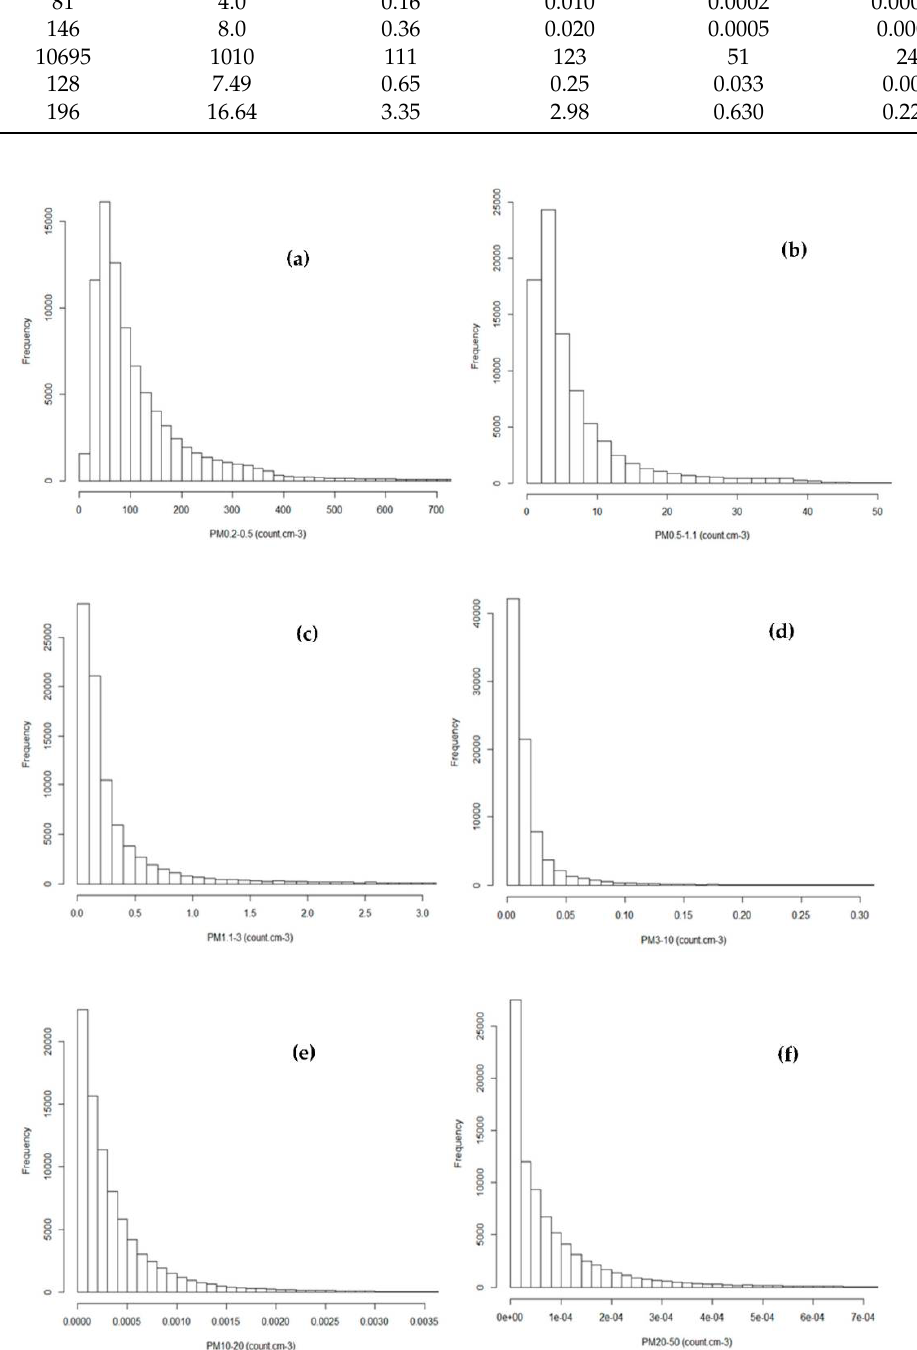
Figure 4. Histogram indicating the number of observations (frequency) of different PM concentrations (count per cm 3 ) for particles of size ranges: ( a ) 0.2–0.5 µm; ( b ) 0.5–1.1 µm; ( c ) 1.1–3 µm; ( d ) 3–10 µm; ( e ) 10–20 µm and ( f ) 20–50 µm in three locations between 2013 and 2019.